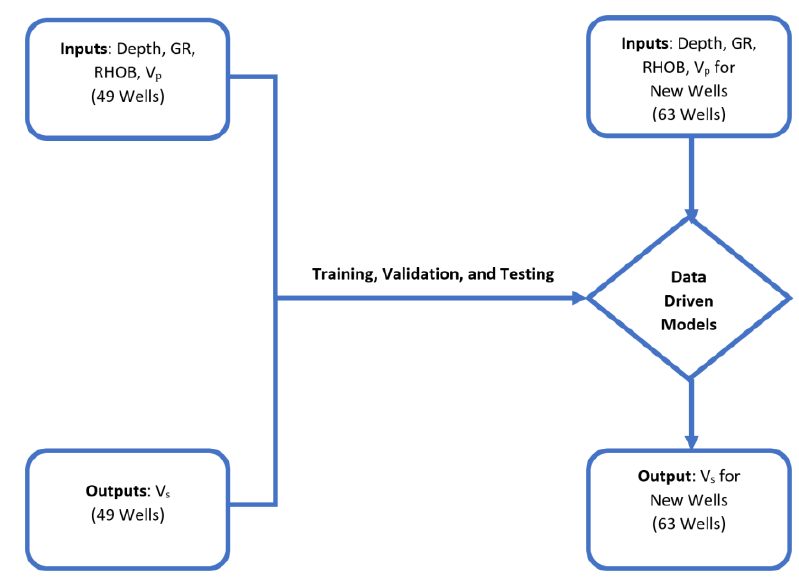
( a ) ( b ) Figure 5. Prediction of shear wave velocity linearly with its training and validation set for ( a ) the Upper Bakken Formation ( b ) Middle Bakken Formation. Step B: Prediction of Shear Wave Velocity from Conventional Well Logs utilizing ANN An ANN model was developed by using conventional well logs as the input and shear wave velocity as the output. Initially, the conventional well logs used were depth, gamma ray (GR), and bulk density (RHOB). The results obtained for predicted shear wave velocity were unsatisfactory, resulting in a very low R 2 , indicating that a pattern was not fully recognized, and an additional input was necessary to improve the reliability of the model. Thus, compressional wave velocity was added as an additional input along with other conventional well logs. Figure 4 shows the distribution of wells with respect to information regarding depth, gamma ray (GR), bulk density (RHOB), compressional wave velocity (V p ), and shear wave velocity (V s ). Figure 6 shows the process flow for the creation of the neural network model using depth, gamma ray (GR), bulk density (RHOB) and compressional wave velocity (V p ) for 49 wells and the output of